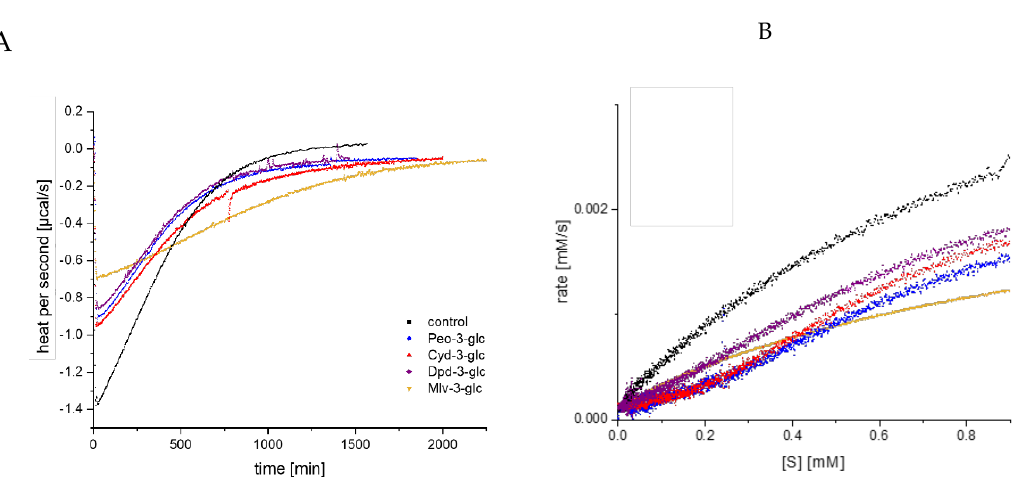
Figure 4. Thermogram (thermal power required to maintain constant temperature) for GalG 2 CNP conversion after addition of α -amylase in the presence of 100 µ M anthocyanin-3-glc ( A ), and respective Michaelis Menten plot ( B ), converted from the thermogram (A). Abbr.: Cyd-3-glc, cyanidin-3-glucoside; Dpd-3-glc, delphinidin-3-glucoside; Peo-3-glc, peonidin-3-glucoside; Mlv-3-glc, malvidin-3-glucoside.